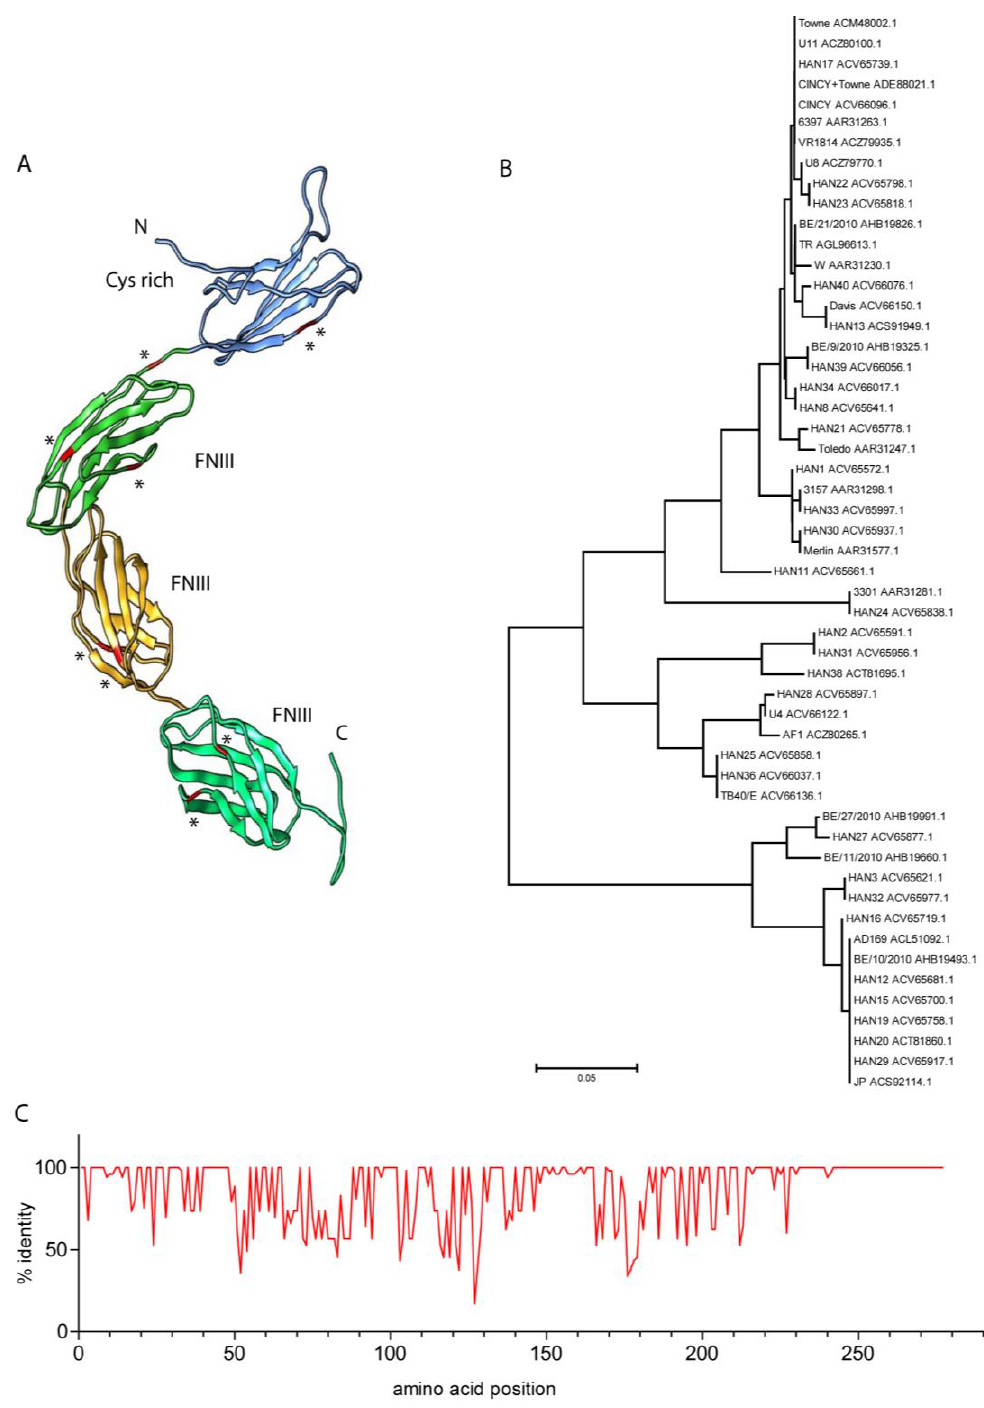
Figure 3. ( A ) The positions of those residues in the extracellular domain of CD45RO that were shown to be under positive selection [81] are labeled in red and marked with asterisks. The model of the CD45 structure was generated with the RaptorX program [84,85] and depicted using UCSF Chimera [86]. ( B ) Phylogenetic representation of 53 UL11 amino acid sequences derived from clinical and laboratory adapted HCMV strains. The phylogeny tree was calculated with MEGA 6 [87]. ( C ) The identity scores of the amino acids along the different positions of UL11 were calculated with the Jalview program